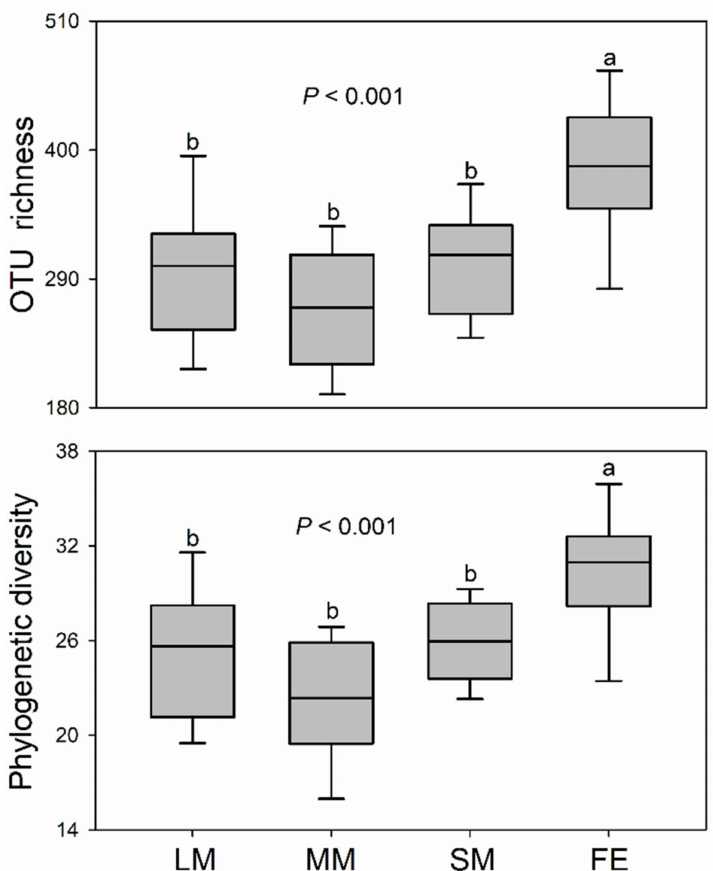
Figure 1. Intestinal bacterial alpha-diversity of Odontolabis fallaciosa across di ff erent treatments. The bottom and top of the box denote the first and third quartiles; the band inside the box denotes the median; letters above bars represent significant di ff erences from the one-way ANOVA with Tukey’s honestly significant di ff erence (HSD) post-hoc testing ( p < 0.05). LM: large male; MM: medium-sized male; SM: small male; FE: female; OTU: operational taxonomic